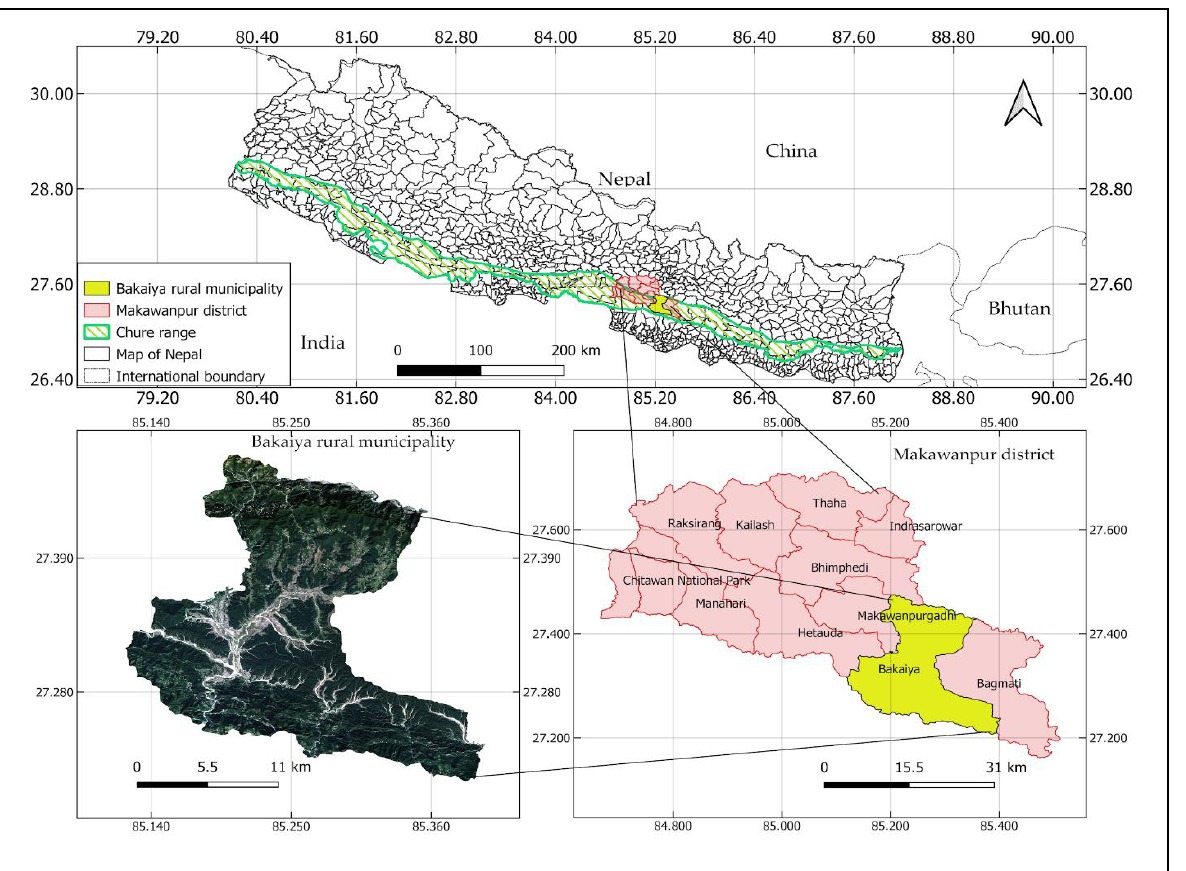
Figure 1. Map showing the study area in Central Nepal.